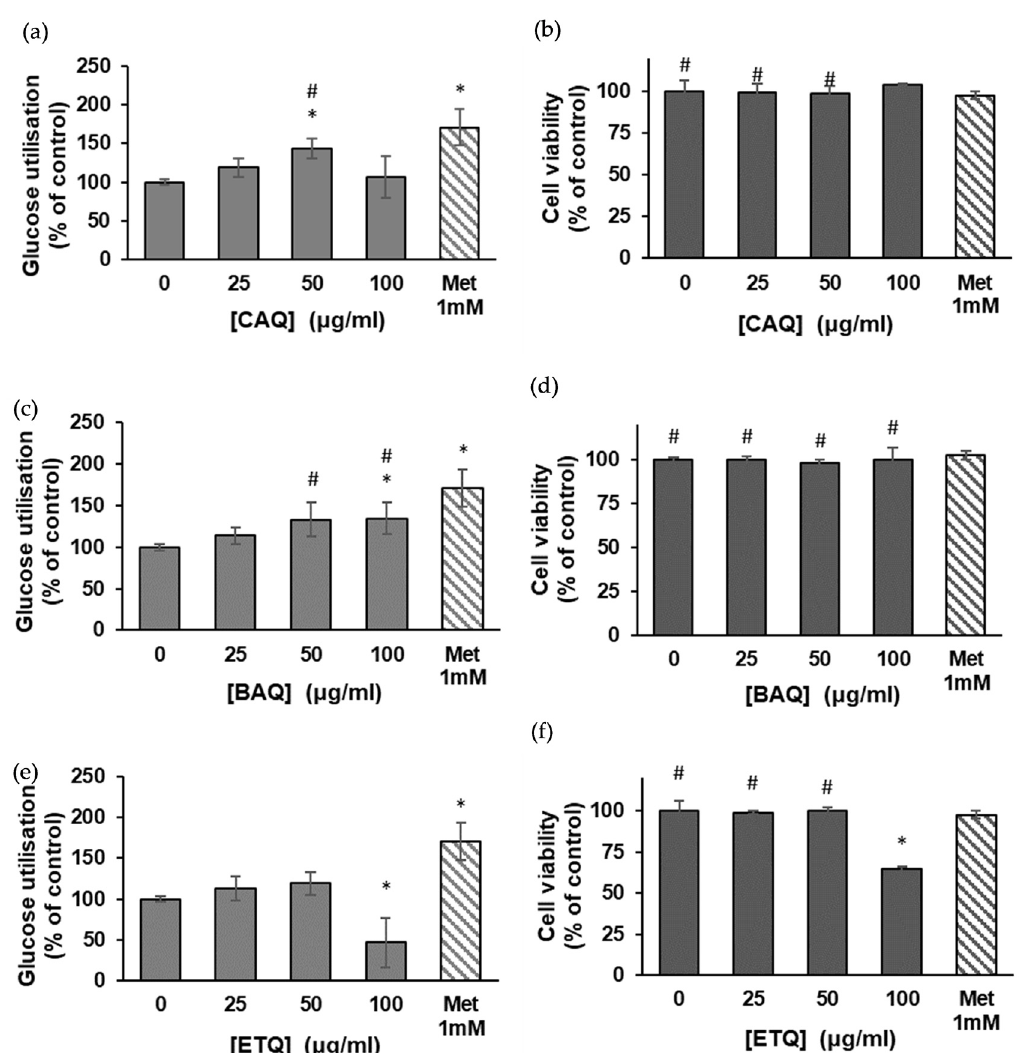
Figure 2. ( a ) Effect of the CAQ extract of H. petiolare on glucose uptake in HepG2 (C3A) hepatocytes (data are expressed as mean ± SD, n = 3); ( b ) MTT cytotoxicity of the plant’s CAQ extract on HepG2 cells (data are expressed as % of control ± SD, n = 3); ( c ) effect of the BAQ extract of H. petiolare on glucose uptake in HepG2 (C3A) hepatocytes (data are expressed as mean ± SD, n = 3); ( d ) MTT cytotoxicity of the plant’s BAQ extract on HepG2 cells (data are expressed as % of control ± SD, n = 3); ( e ) effect of the ethanol extract of H. petiolare on glucose uptake in HepG2 (C3A) hepatocytes (data are expressed as mean ± SD, n = 3); ( f ) MTT cytotoxicity of the plant’s ethanol extract on HepG2 cells (data are expressed as % of control ± SD, n = 3). * Indicates a significant difference (p < 0.05) compared to the untreated control, and # indicates no significant difference relative to the positive control (metformin). BAQ, boiled aqueous; CAQ, cold aqueous; ETQ, ethanol; Met,